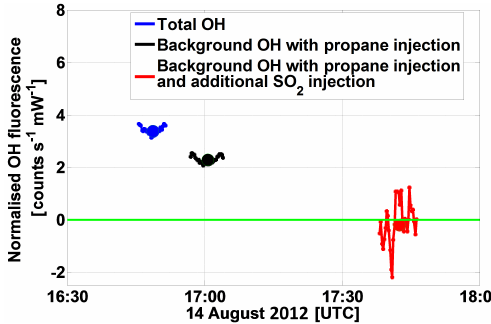
Figure 10. SO 2 injection test within IPI during the HOPE 2012 campaign. The blue data points represent the total OH mea- sured when no injection is performed. The black data points represent the background OH measured while injecting propane (2.5 × 10 15 moleculescm − 3 ) scavenging>90% of ambient OH. The red signal is the background OH observed when SO 2 (1.0 × 10 13 moleculescm − 3 ) is injected in addition to